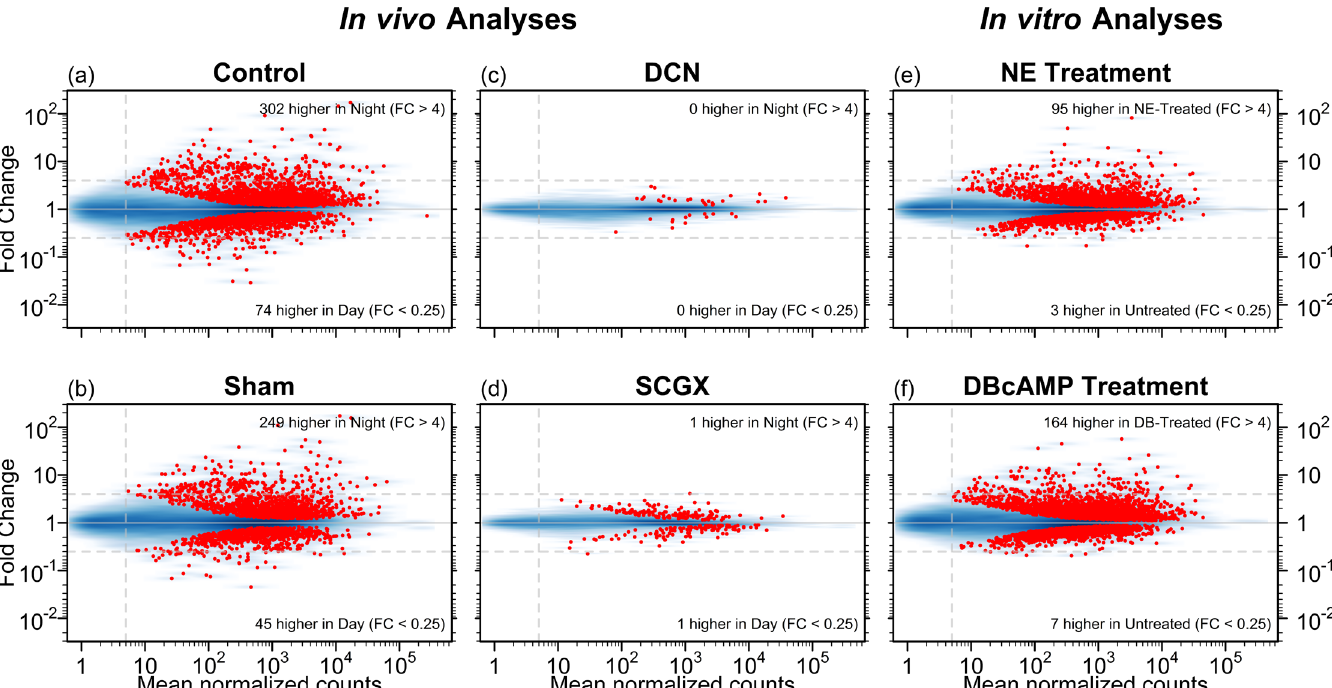
Fig 1. MA plots for six differential expression analyses. These plots display the mean normalized read-pair counts (x-axis) versus the estimated fold change (y-axis), on a log-log scale for four in vivo analyses and two in vitro analyses. The blue shading indicates the density of genes, and each red point represents a gene with statistically significant differential expression (adjusted-p < 0.001). Dashed horizontal lines mark 4-fold changes in both directions, dashed vertical line indicates minimum abundance threshold for the statistical tests. The four in vivo analyses compared night and day time points in adult rats for the following groups: (a) no surgery (Control); (b) neonatal sham surgery (Sham); (c) neonatal superior cervical ganglia decentralization (DCN); (d) neonatal superior cervical ganglionectomy (SCGX). The two in vitro analyses compared treated/untreated pineal glands: (e) norepinephrine-treated (NE) vs untreated and (f) dibutyryl-cyclic-AMP-treated (DBcAMP) vs untreated.